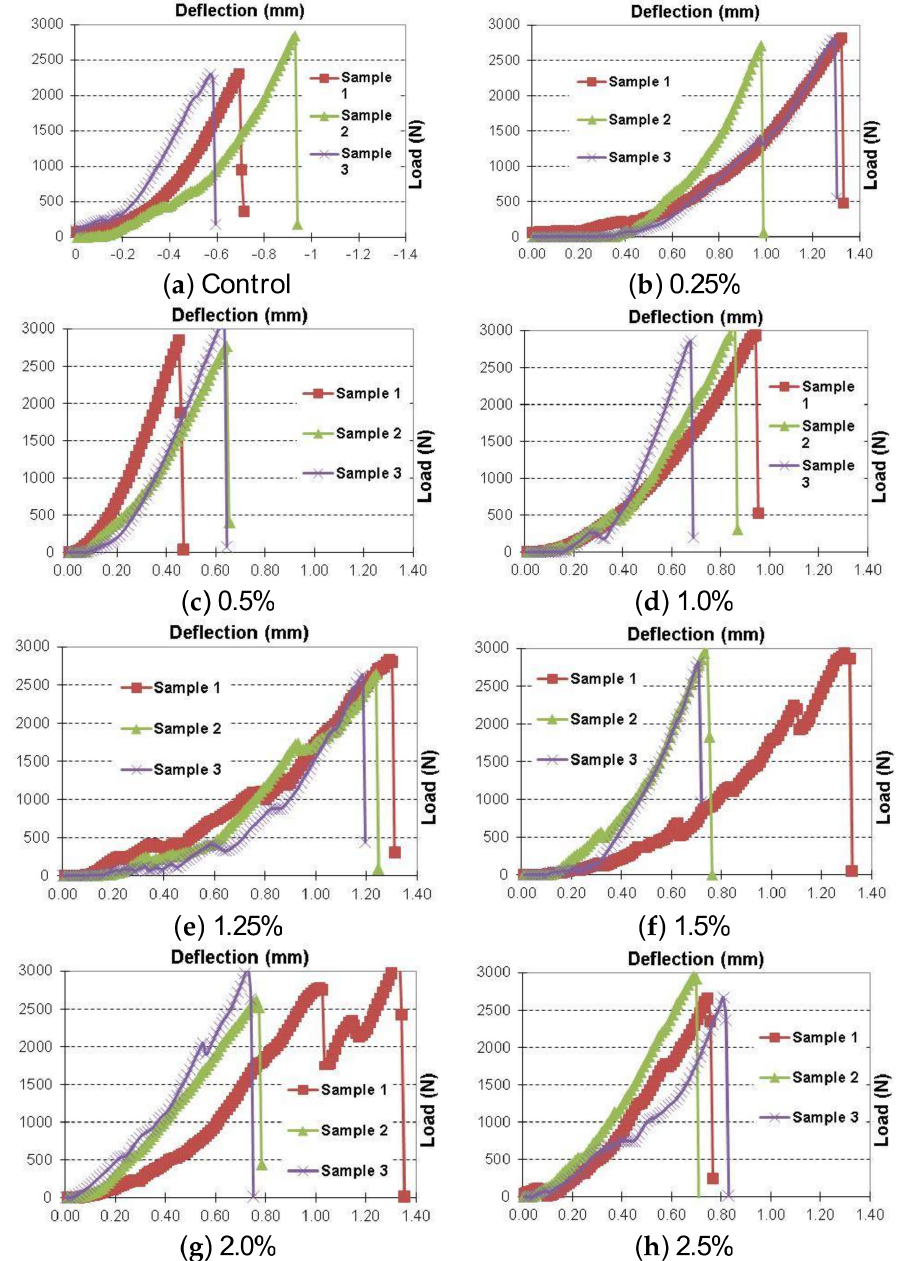
Figure 12. Load-deflection relationships due to freeze and thaw